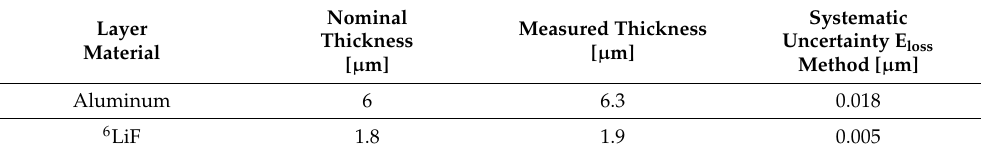
Table 2. The nominal and measured thickness of the aluminum and 6 LiF layers, assuming standard densities. The quoted systematic uncertainty due to the energy loss method employed is basically